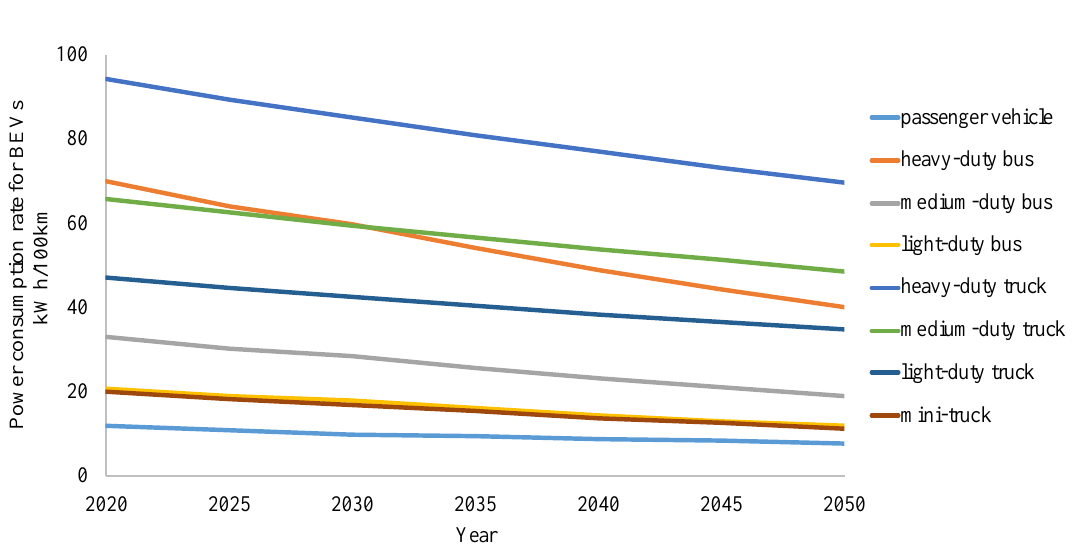
Figure 3. Power consumption rate for BEVs assumed in this study.